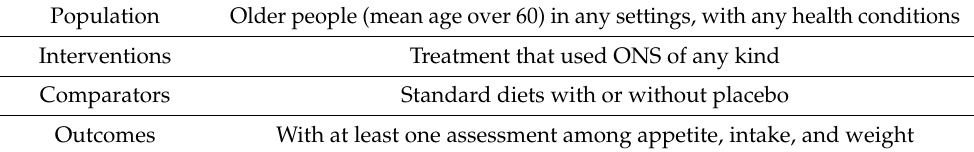
Table 1. PICO statement for studies’